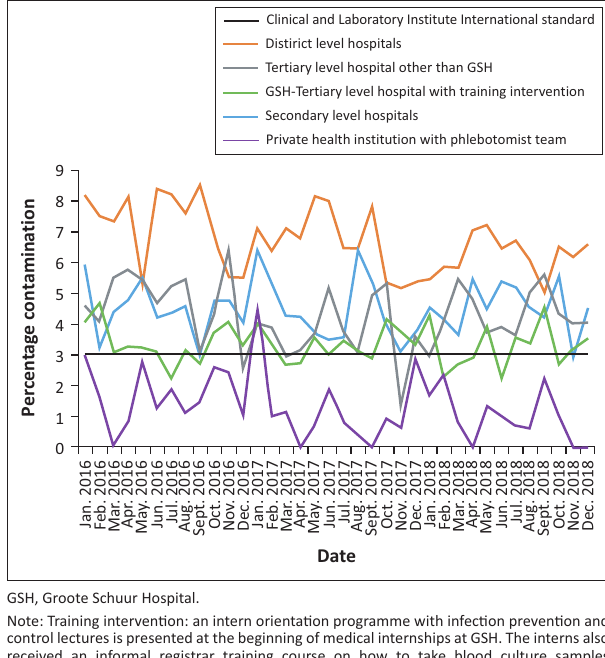
FIGURE 1: Blood culture contamination rates in different level hospitals with and without the educational intervention compared to the Clinical and Laboratory Institute International standard benchmark of 3 % , between 01 January 2016 and 31 December